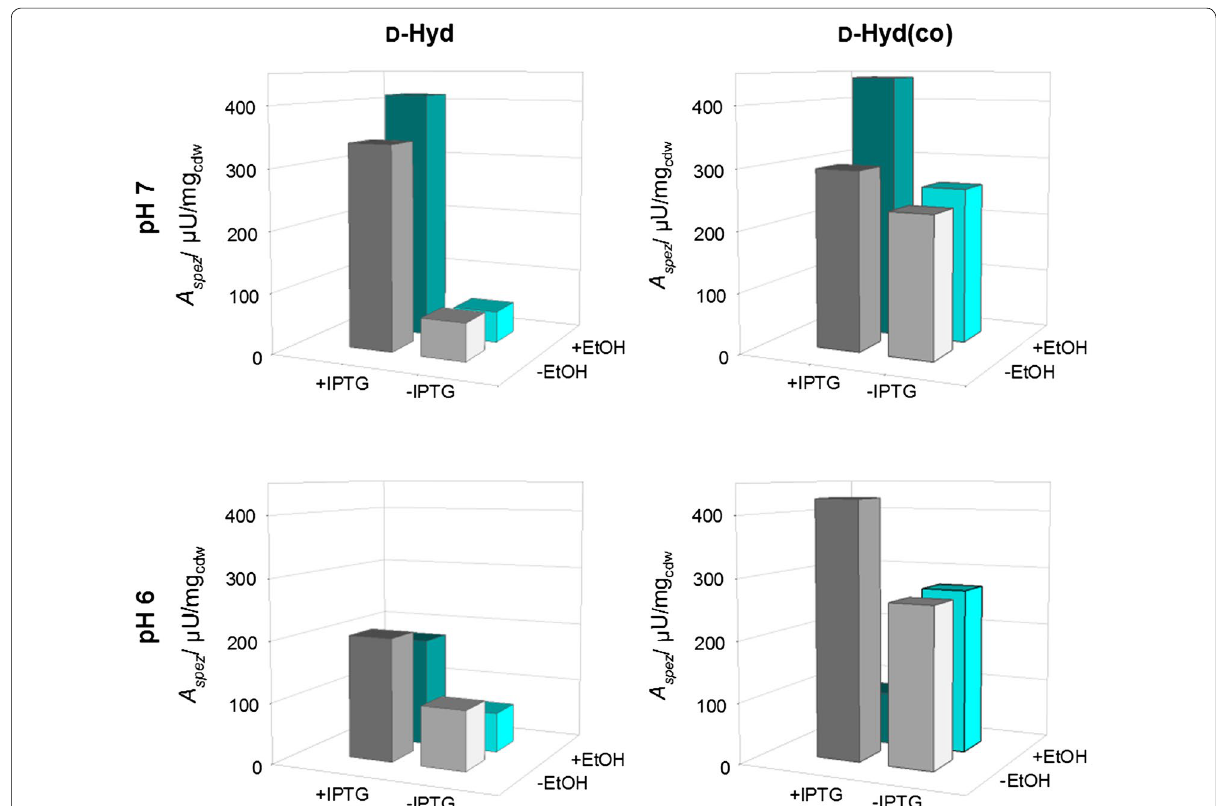
Fig. 5 Screening for cultivation conditions of E. coli BL21DE3 expressing d -Hyd and d -Hyd(co). Specific activities after whole cell biotransformation with 2 mM PheHyd after cultivation and induction under different conditions. cyan ), EtOH IPTG ( cyan + −